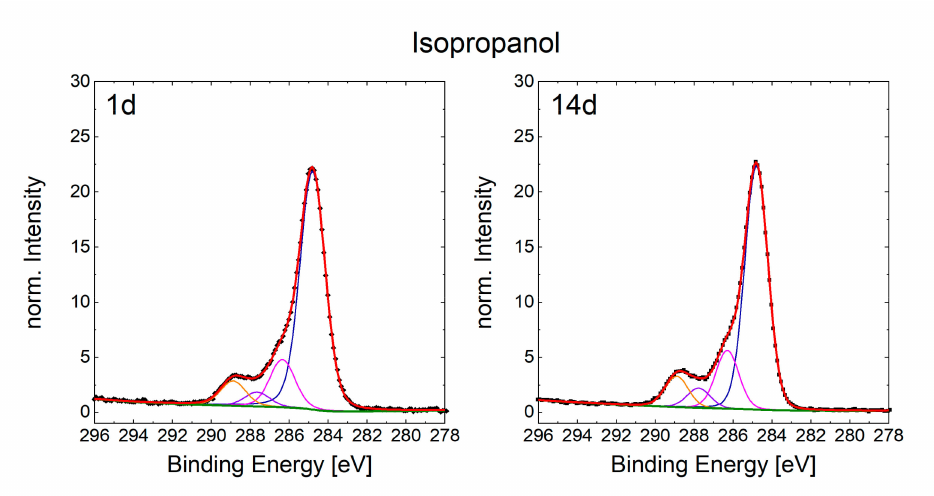
Figure A4. C 1s spectra of structured sample 1 and 14 days after cleaning with isopropanol.